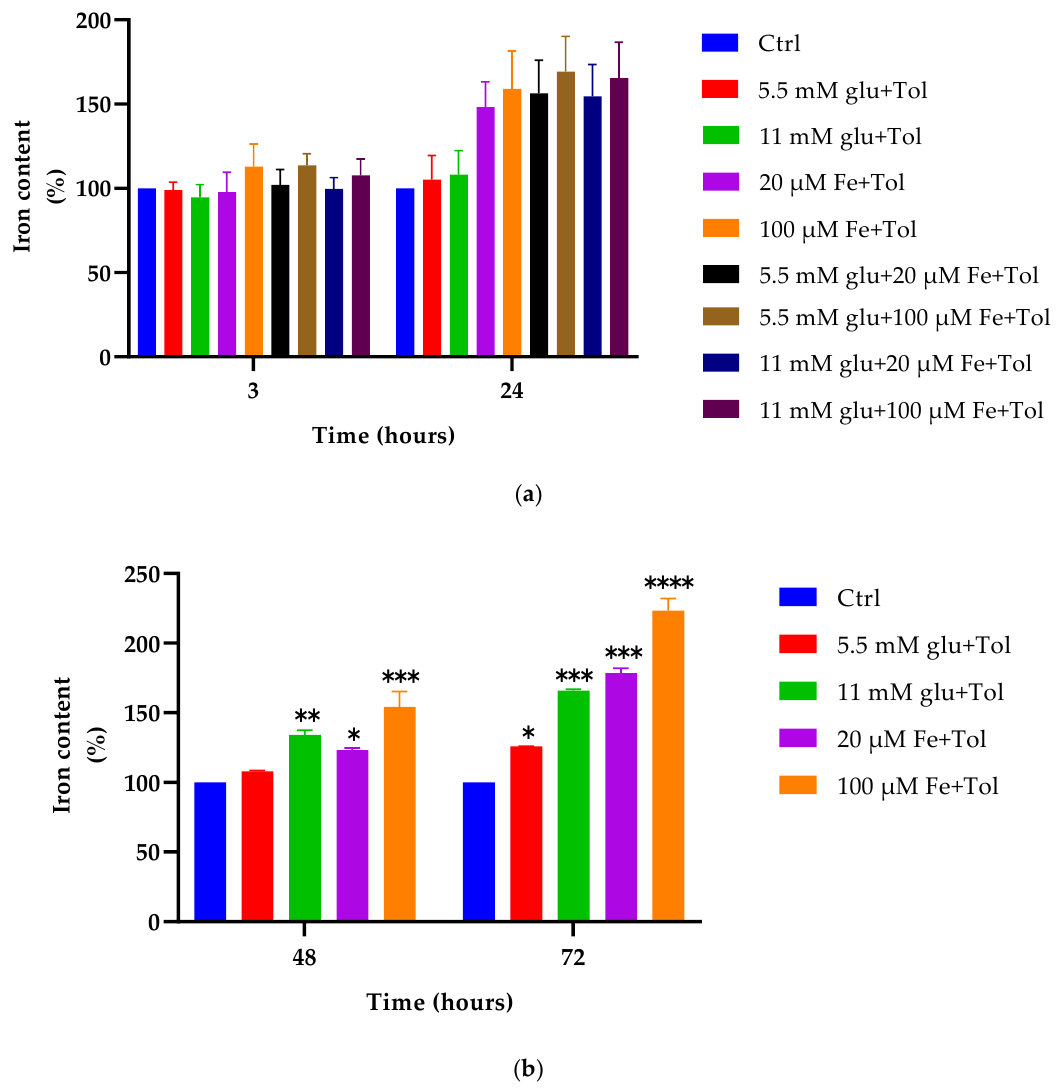
Figure 2. Effect varying of iron and glucose concentrations on intracellular iron content. To quantify the intracellular accumulation of iron, MIN6 cells were exposed to iron (20 μM and 100 μM) and/or glucose (5.5 mM and 11 mM) with the addition of tolbutamide as a secretagogue. Cells were incubated in a time course at 3 and 24 h ( a ), 48 and 72 h ( b ). End points measurements were determined using FerroZine™-based colorimetric assay. The data represent mean ± SEM, n = 4. Significance compared to control are as follows ** p < 0.004 (11 mM Glu (C2)—48 h), * p < 0.017 (C3—48 h), *** p < 0.0004 (C4—48 h); * p < 0.014 (5.5 mM Glu (C1)—72 h), *** p < 0.001 (C2—72 h), *** p < 0.0003 (C3—72 h), **** p < 0.0001 (C4—72 h).